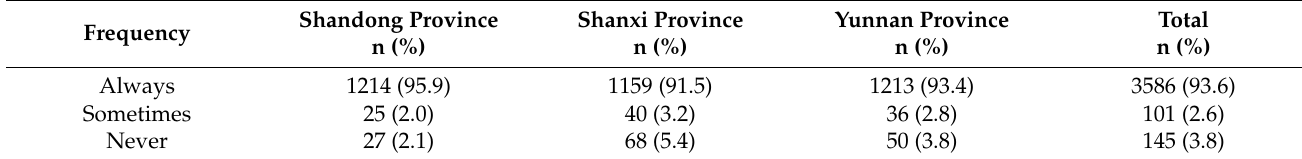
Table 2. Mask-wearing by 3832 rural residents.